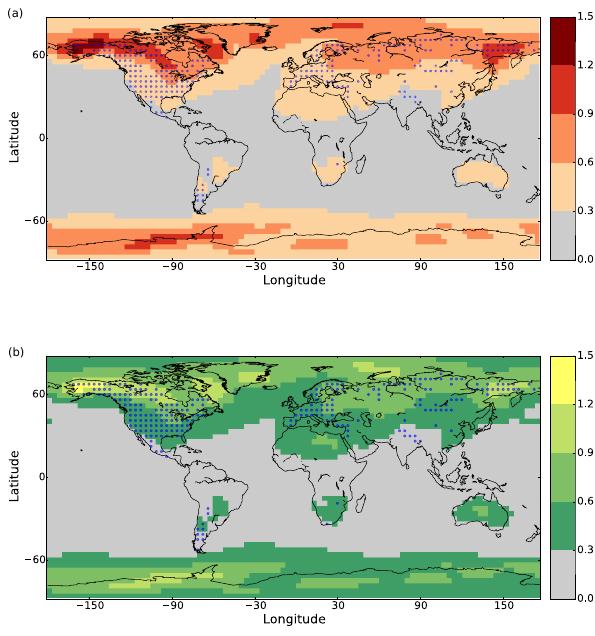
Figure 3. Yearly near-surface temperature spread (a) and RMSE (b) for the free ensemble run.